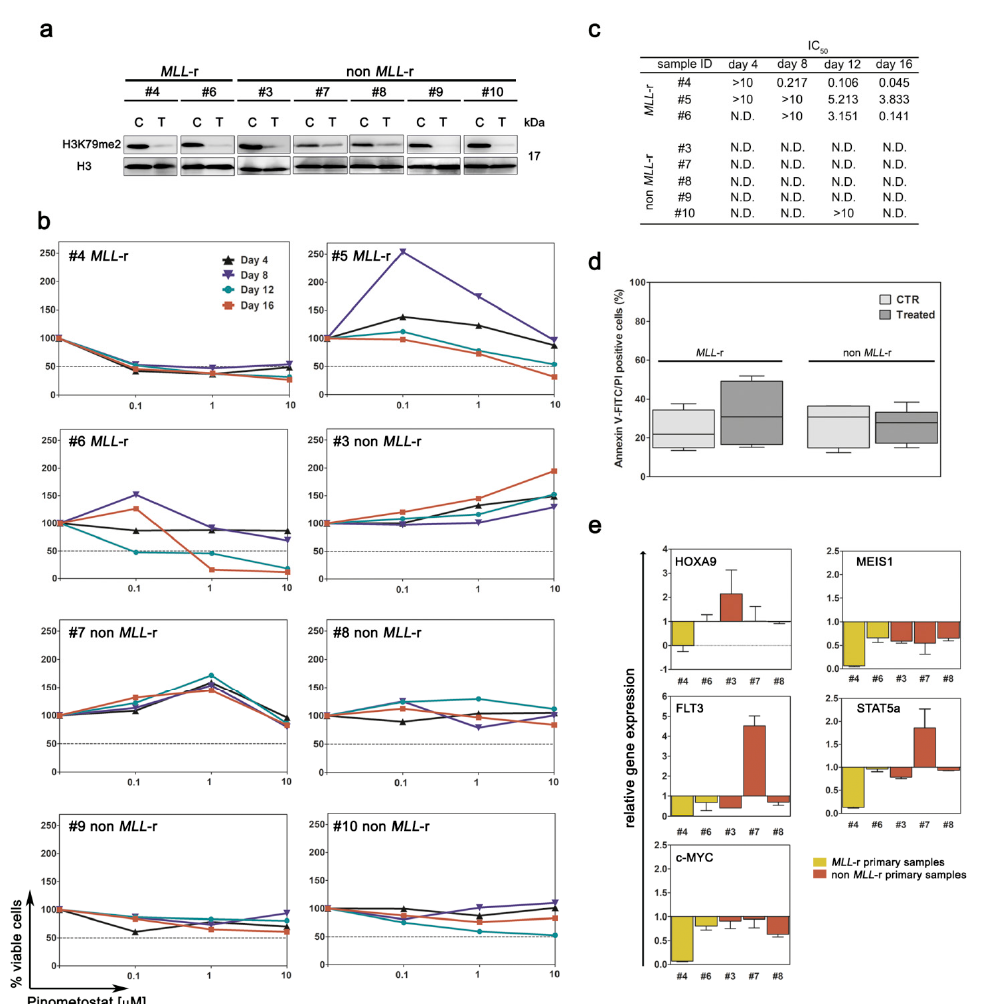
Figure 3. Pharmacological targeting of DOT1L in primary AML cells derived from pediatric patients with or without MLL -r. Primary AML cells were treated with Pinometostat for up to 16 days. ( A ) Western blot analysis of H3K79me2 levels following 8 days of treatment with 1 µM of Pinometostat or DMSO 0.01%. Molecular weights are indicated on right. C: control cells; T: treated cells. ( B ) Growth curves of primary AML cells treated with increasing concentrations of Pinometostat for up to 16 days. ( C ) Summary of IC 50 concentrations. ( D ) Average percentage of apoptotic cells measured by flow cytometry in MLL -r and non- MLL -r primary AML cells treated for 16 days with 1 µM of Pinometostat or DMSO 0.01%. Ctr: control cells. Data are presented as means ± SD. ( E ) Modulation of gene expression induced by 8 days of treatment with 1 µM of Pinometostat and quantified by RT-PCR. Relative mRNA expression in treated vs. control cells was calculated using the 2 −ΔΔ Ct methods. Results of three independent replicates are presented as means ± SD.